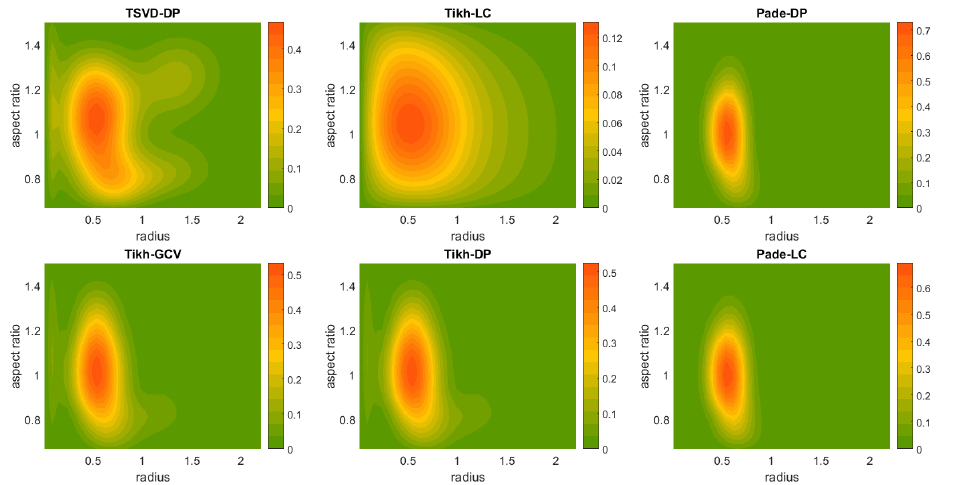
Figure A2. Retrieved shape-size distributions from synthetic data produced with RI: 1.5 + 0.01i, 1% data error, the size distributions No. 3 and sphere-spheroid particle ensembles. The uppermost plot corresponds to the initial shape-size